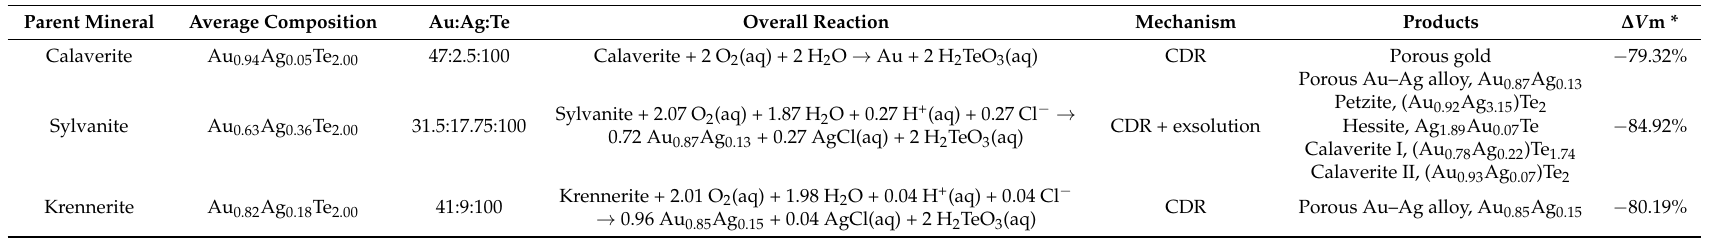
Table 2. Summary of experimental replacement reactions of gold–(silver) tellurides under hydrothermal